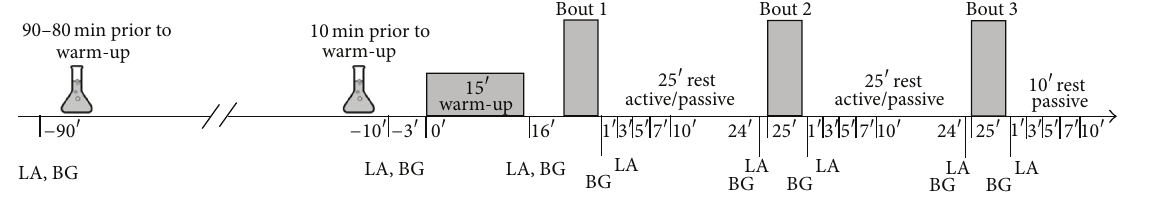
Figure 1: Illustration of the general design of the